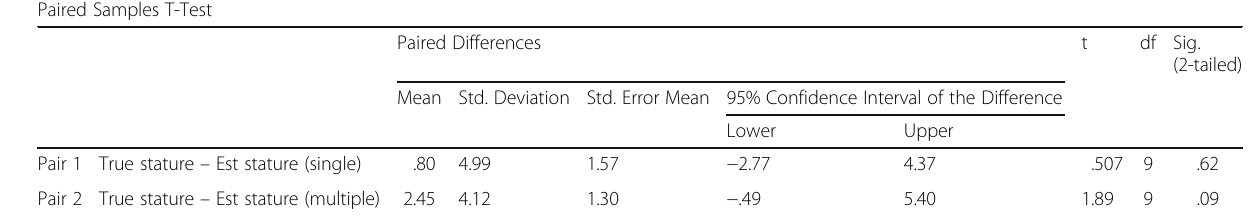
Table 4 Paired T-test between true and estimated stature Paired Samples T-Test